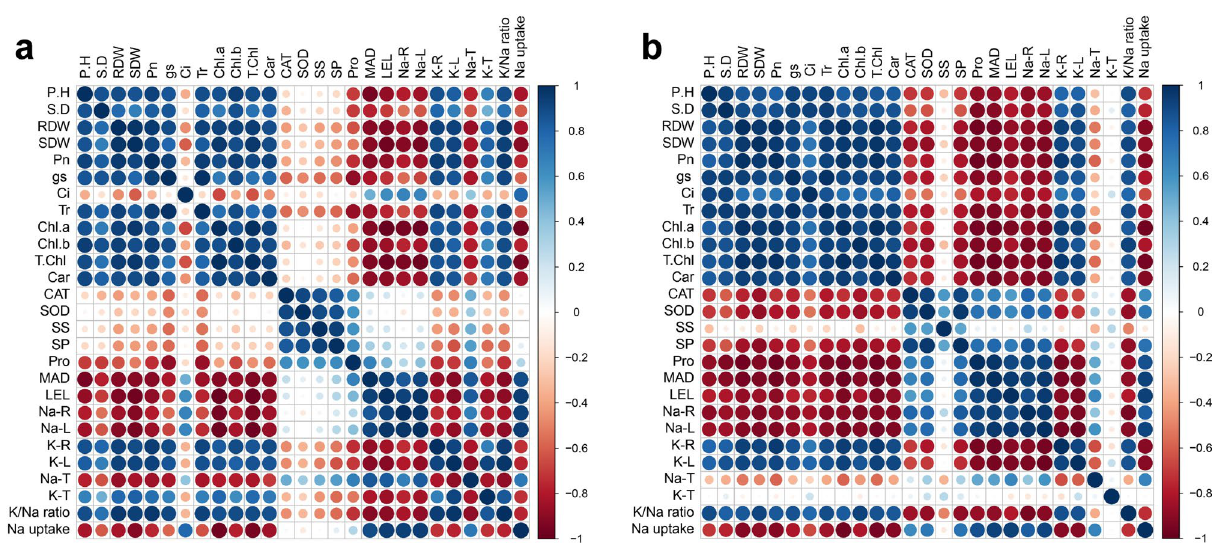
Figure 8. Correlation analysis (P < 0.05) between various measured attributes of Glycyrrhiza uralensis (a) and G. inflata (b) . The abbreviations are as follows: PH (plant height), SD (stem diameter), SDW (shoot dry weight), RDW (root dry weight), Pn (net photosynthesis rate), Tr (transpiration rate), Gs (stomatal conductance), Ci (internal CO 2 concentration), Chl a (chlorophyll a ), Chl b (chlorophyll b ), T. Chl (total chlorophyll), Car (carotenoid content), SOD (superoxidase activity), CAT (catalase activity), SS (soluble sugar content), SP (soluble protein content), Pro (proline content), MDA (malondialdehyde content), LEL (leaf electrolyte leakage), Na-R (sodium concentration in roots), Na-L (sodium concentration in leaves), K-L (potassium concentration in leaves), K-R (potassium concentration in roots), Na-T (Na + translocation), K-T (K + translocation), K/Na ratio (K + /Na + ratio), Na uptake (Na +